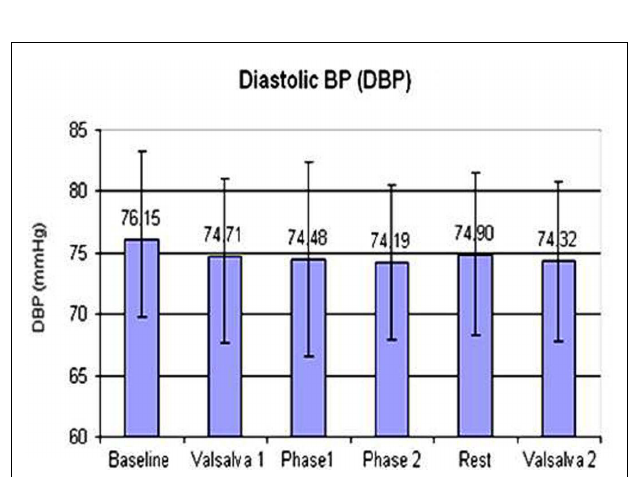
FIGURE 2 |The changes in diastolic blood pressure (DBP) across the tasks.